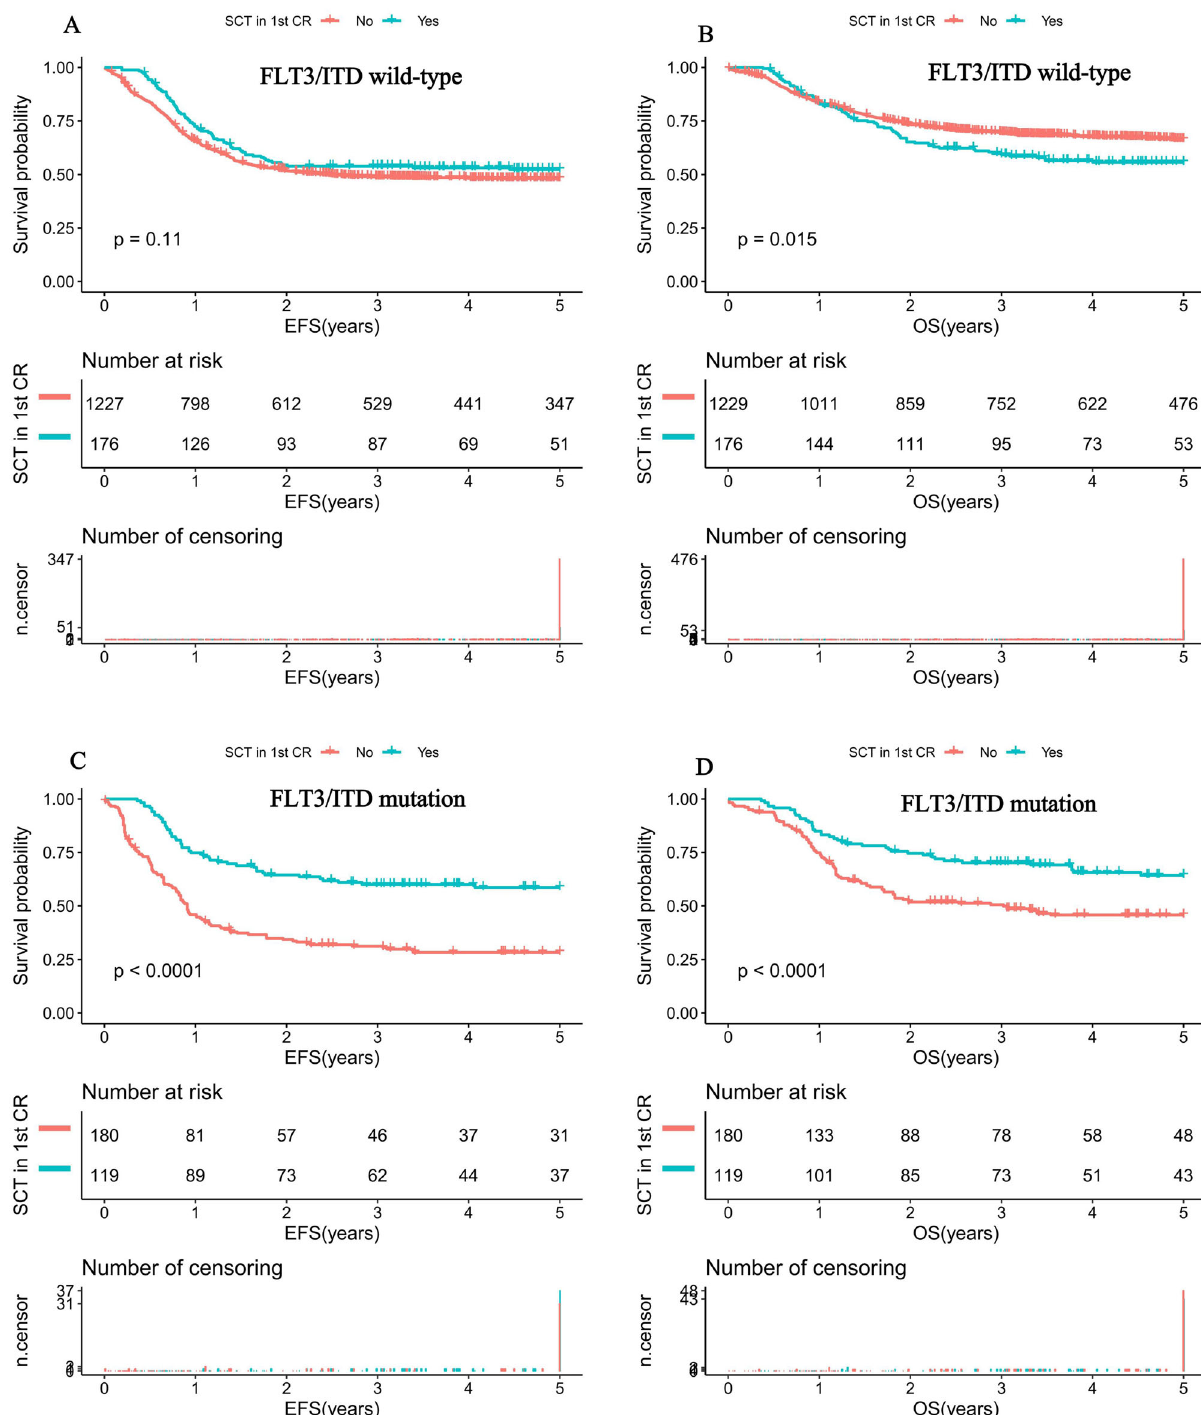
Fig. 3 Survival curves of pediatric AML patients according to FLT3/ITD status and SCT status. A Probability of EFS for patients with FLT3/ITD wild-type according to SCT status. B Probability of OS for patients with FLT3/ITD wild-type according to SCT status. C Probability of EFS for patients with FLT3/ITD mutation according to SCT status. D Probability of OS for patients with FLT3/ITD mutation according to SCT status. AML acute myeloid leukemia, AR allelic ratio, EFS event-free survival, OS overall survival. EFS and OS were evaluated by the Kaplan – Meier method and compared by log-rank test. Source data are provided as a Source Data fi